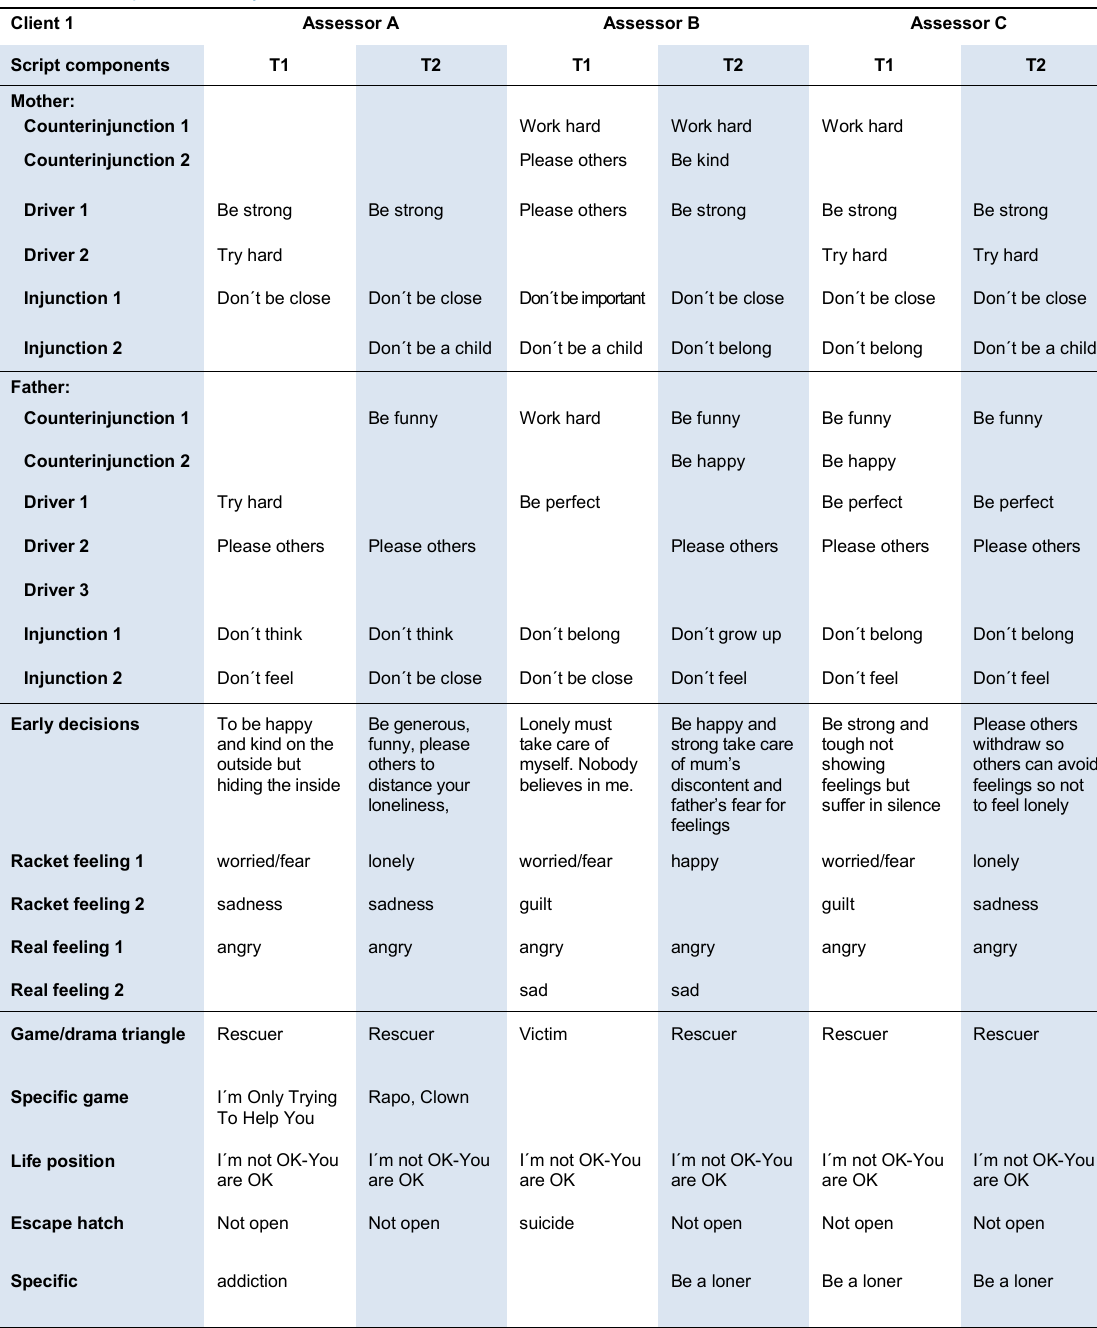
Table 1: Example: Summary of assessments for a client Client 1 Assessor A Assessor B Assessor